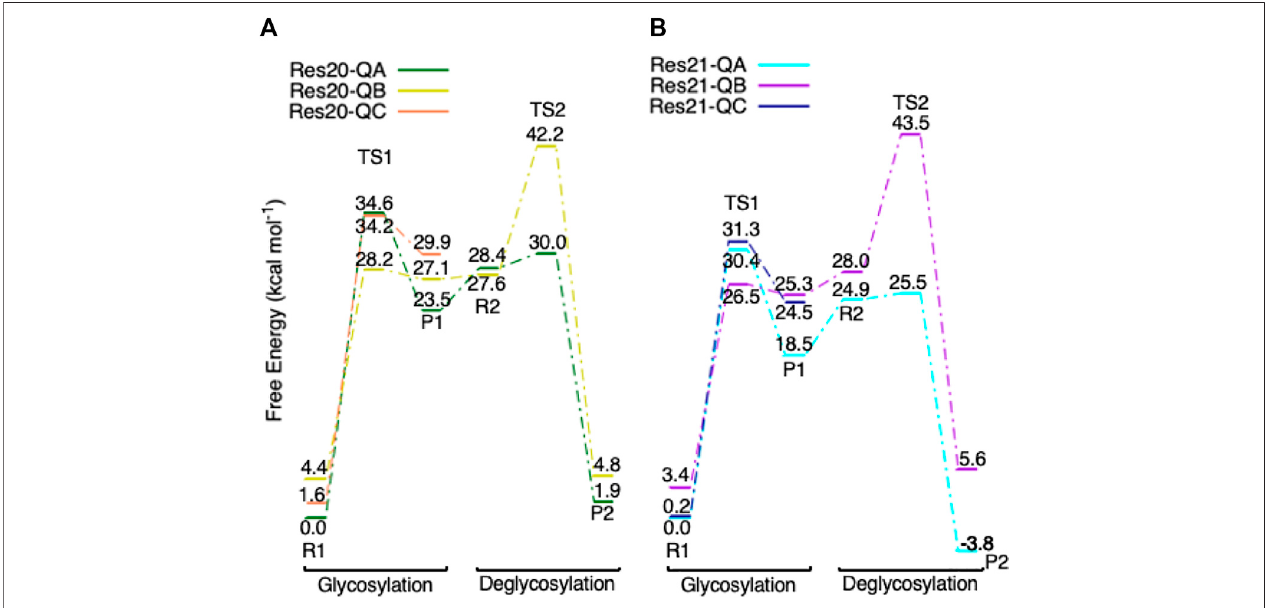
FIGURE 11 | Free energy diagram of glycosylation and deglycosylation for different conformers of models ( A, left ) Res20-Q and ( B, right ) Res21-Q based on 4C4C.